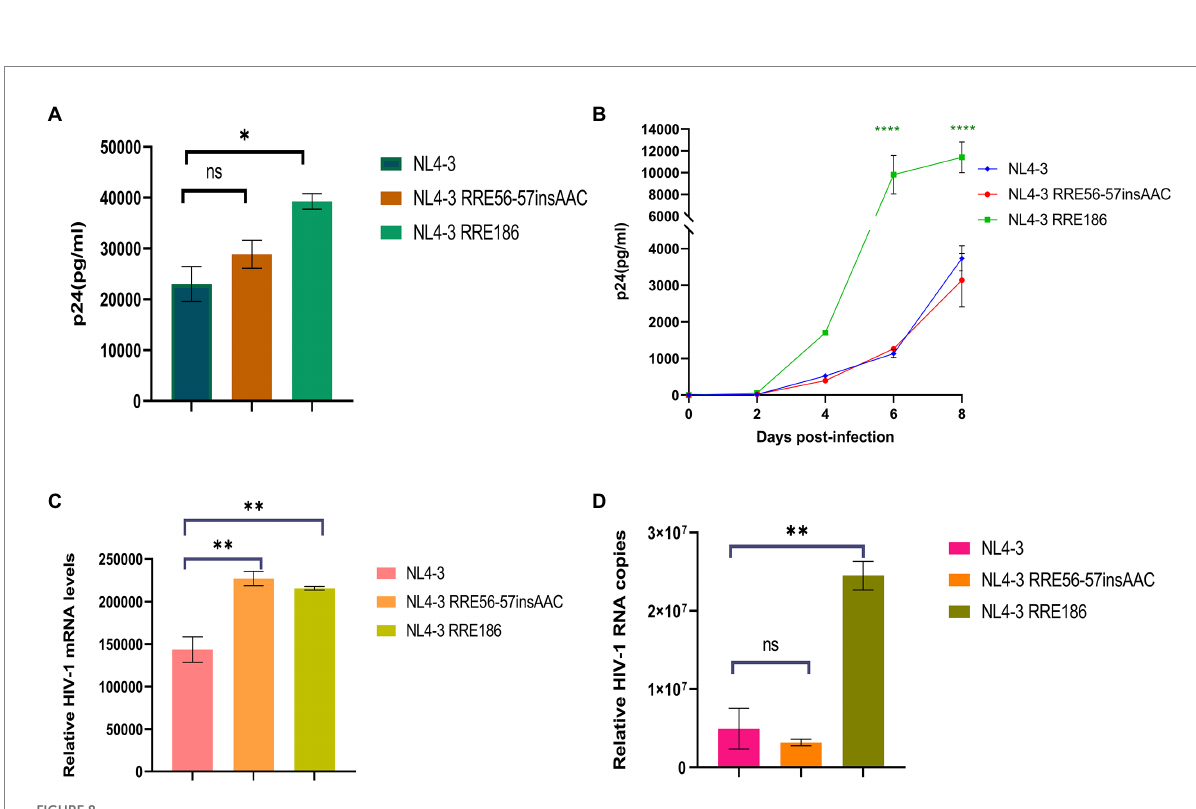
FIGURE 8 Relative viral replication levels of NL4-3 strain and mutant RREs. (A) The replication level of the HIV-1 virus after NL4-3 and mutant RREs plasmid transfection into 293 T cells. (B) The replication level of the corresponding virulent strain in MT2 cells. (C) The mRNA transcript levels in intracellular. (D) The viral RNA copies in cell culture supernatant. Each experiment was repeated twice, and bars show the standard error of the mean from two replicates. * p < 0.05, ** p < 0.01, *** p < 0.001, and **** p < 0.0001, compared to